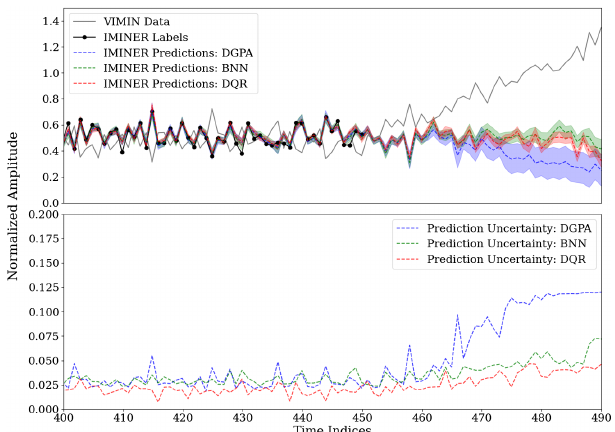
FIG. 7. Comparison of the predictive performance with un- certainty quantification between DGPA, BNN, and DQR, re- spectively for a manually induced OOD. We manually increased the VIMIN input variable at time index 450 to induce the OOD